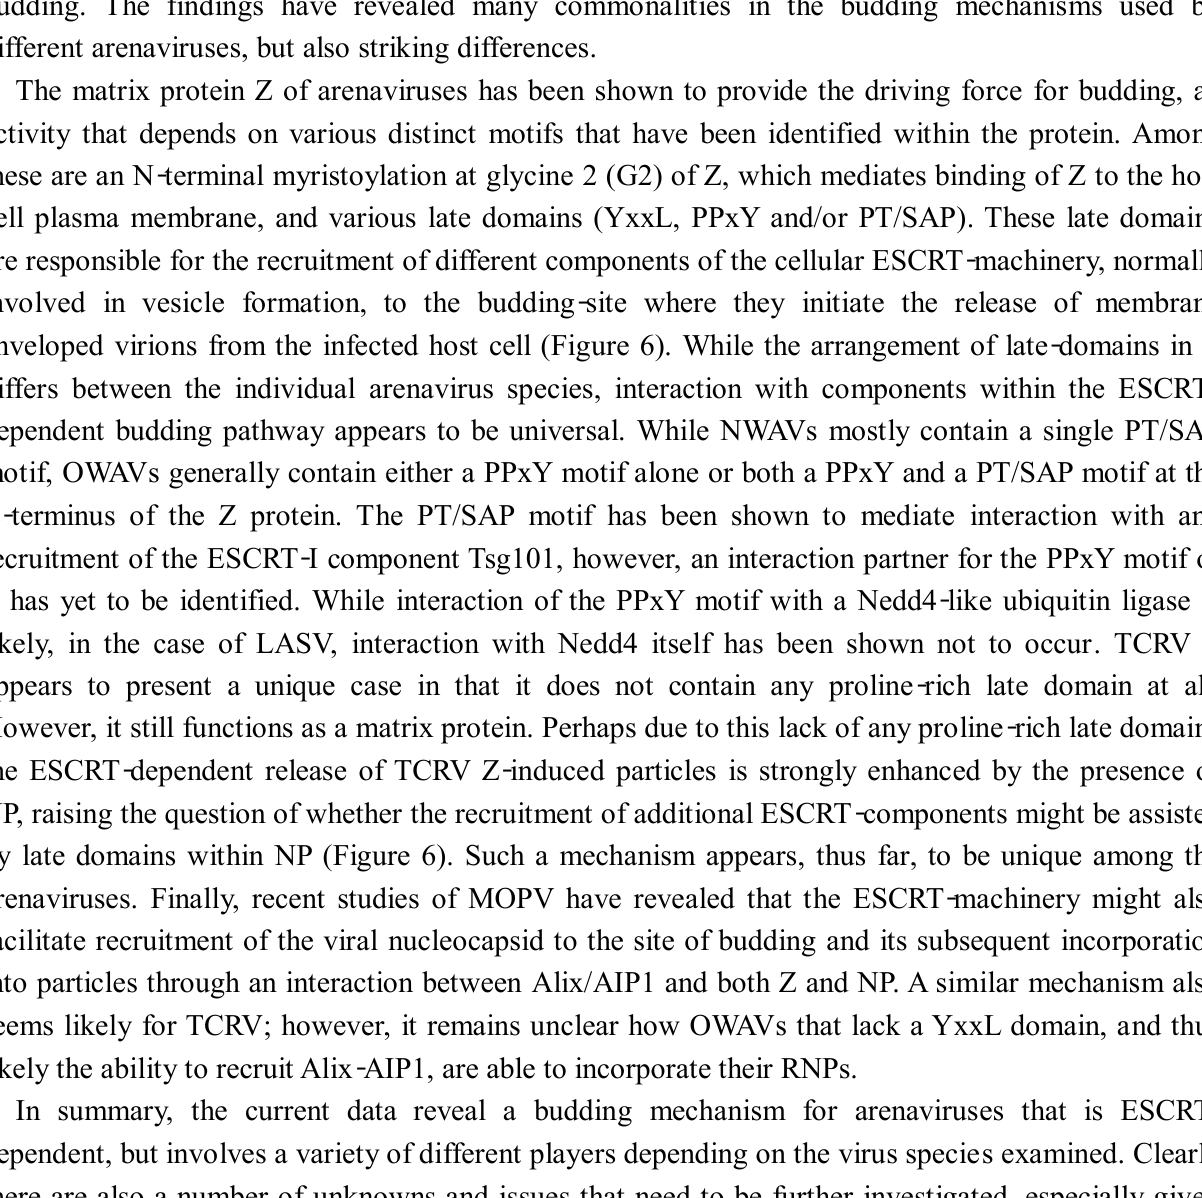
Figure 6. Model of arenavirus budding and the role of the ESCRT pathway.